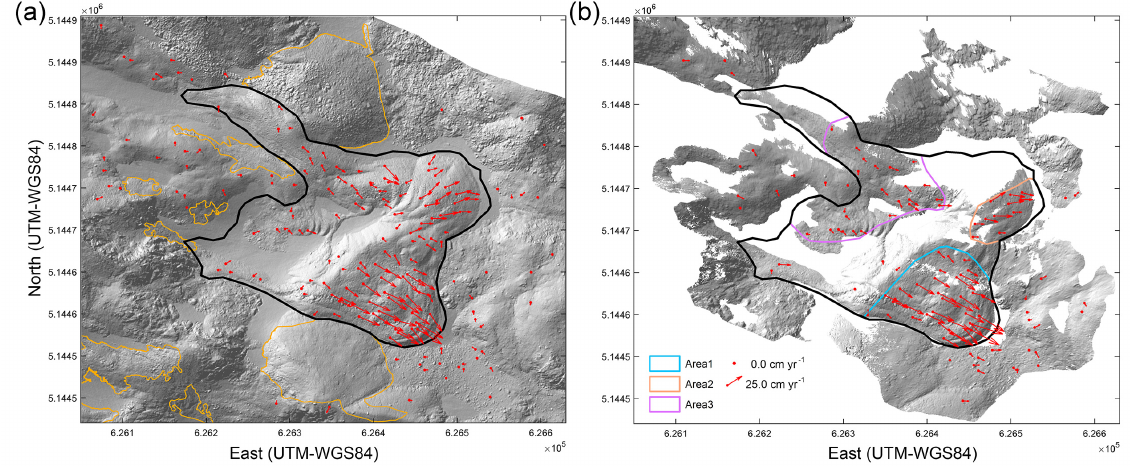
Figure 20. Displacement vectors of the rock glacier between 2003 and 2014 computed by a manual identification of natural features visible in the hillshaded DEMs generated by (a) ALS for both survey epochs and by (b) ALS and photogrammetry for 2003 and 2014 survey,